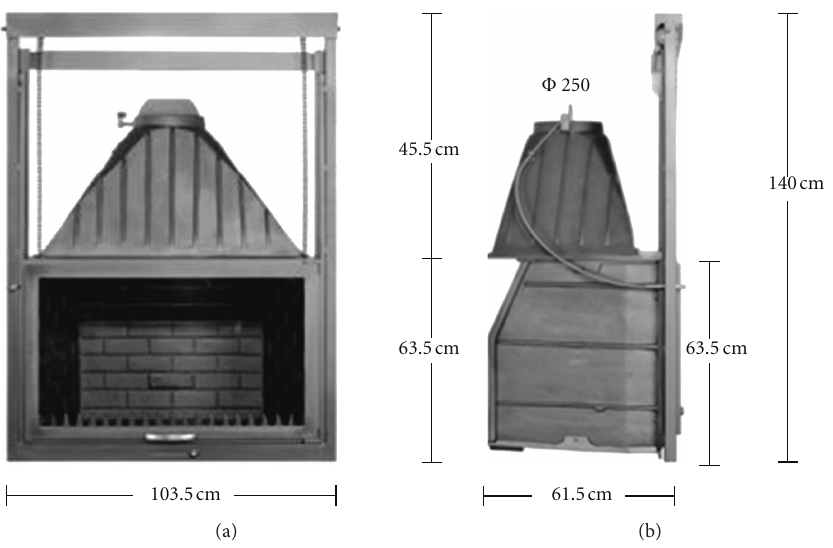
F 1: �iew of the open �re place